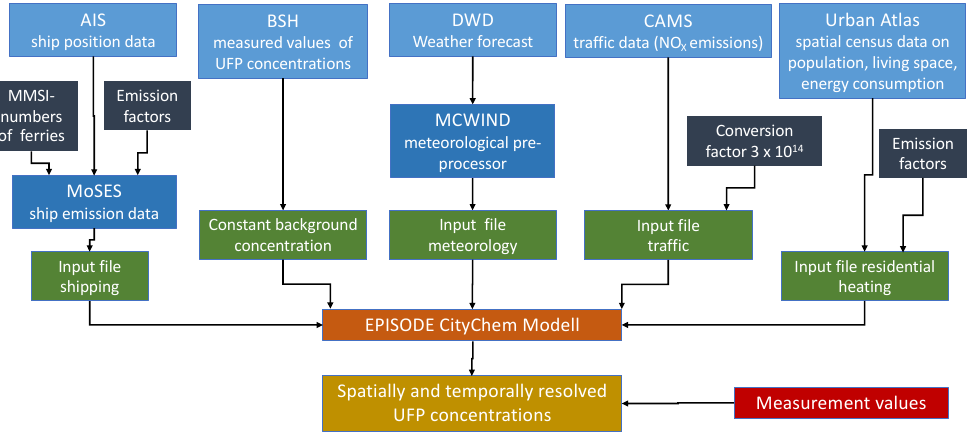
Figure 2. Overview of the model processing chain. Blue: data sources; green: input files; orange/red: output sources; yellow: concentration values.